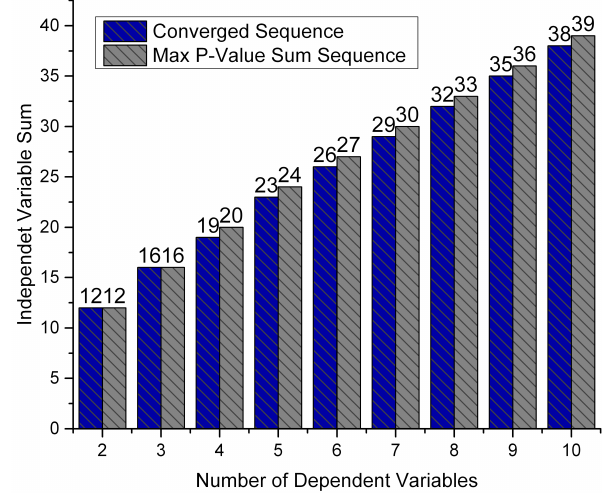
Figure 7. Divergence of Orion algorithm.